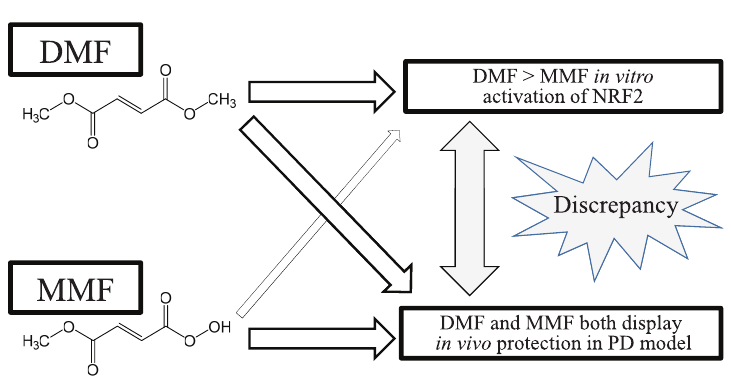
Figure 2. Discrepancy between in vivo and in vitro actions of DMF and MMF in murine PD models. DMF and MMF show comparable protective action in an in vivo rodent model of PD. In contrast, MMF is far less potent than DMF in terms of in vitro NRF2 activation 37,38 . There are at least two possible explanations for this discrepancy. One possible interpretation is that DMF and MMF display differential ADME/T (absorption, distribution, metabolism, excretion, toxicity) parameters in vivo 37,38 . Another possible explanation is that reaction with HCAR2 or another target mediates the protective effects by DMF 37,38 . DMF, dimethyl fumarate; HCAR2, hydroxycarboxylic acid receptor 2; MMF, monomethylfumarate; NRF2, nuclear factor erythroid 2-related factor 2; PD, Parkinson’s